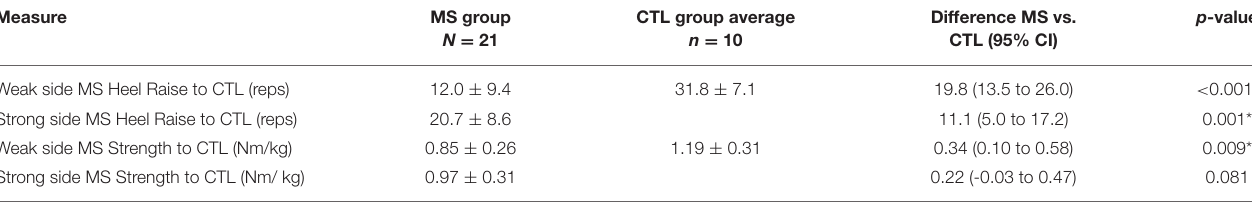
TABLE 2 | Comparison of muscle performance assessments between the MS group (weak and strong sides) and average CTL group values.